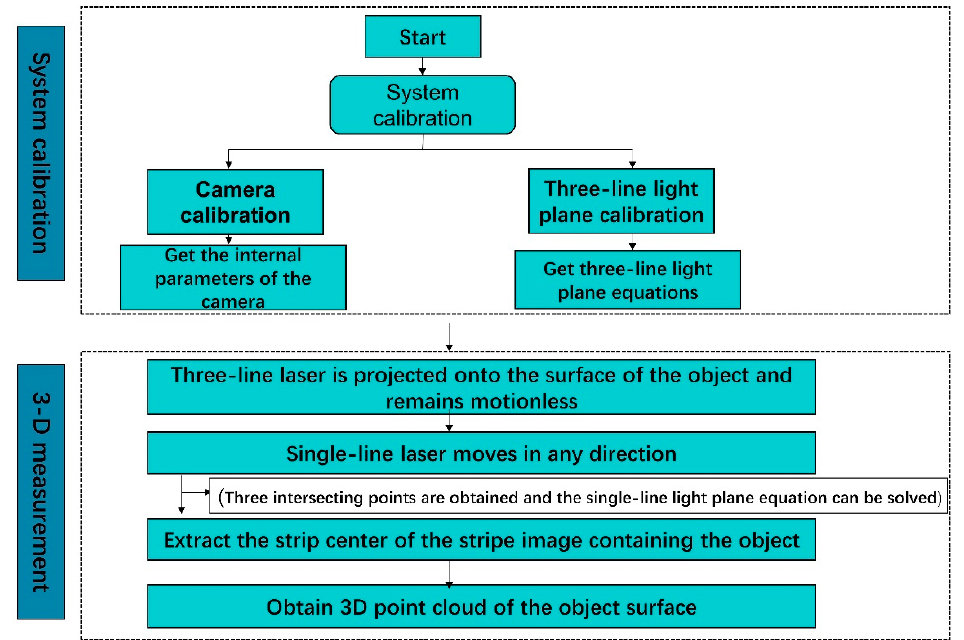
Figure 3. System measurement flow chart.